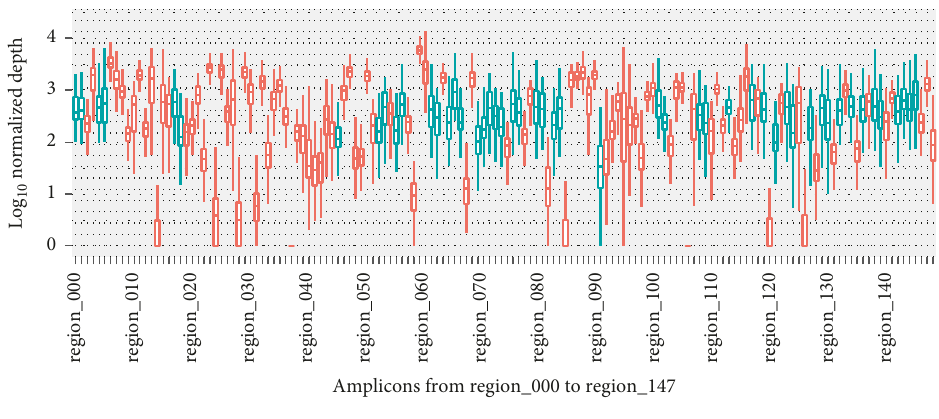
Figure 5: Genome-wide amplicon bias in the 304 clinical samples. Distributions of counts for each amplicon from region_000 to region_147 among the 304 clinical samples are shown. Read numbers per 100,000 mapped reads were log10-transformed to calculate normalized count values. Amplicons with biotinylated primers are marked in blue (biotinylated). Amplicons without biotinylated primers are shown in red (normal). For each distribution, the box plot shows the 1 st quantile, median, and 3 rd quantile